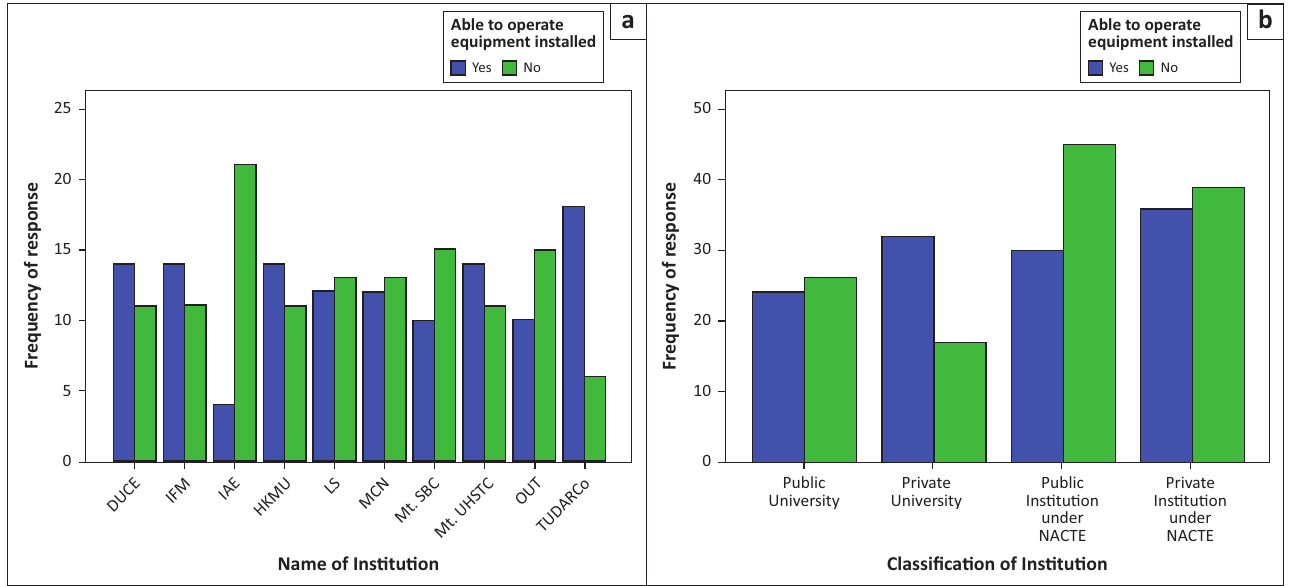
FIGURE 3: Knowledge on the use of the installed fire facilities in the selected institutions. (a) Responses per institution and (b) responses per institution category.